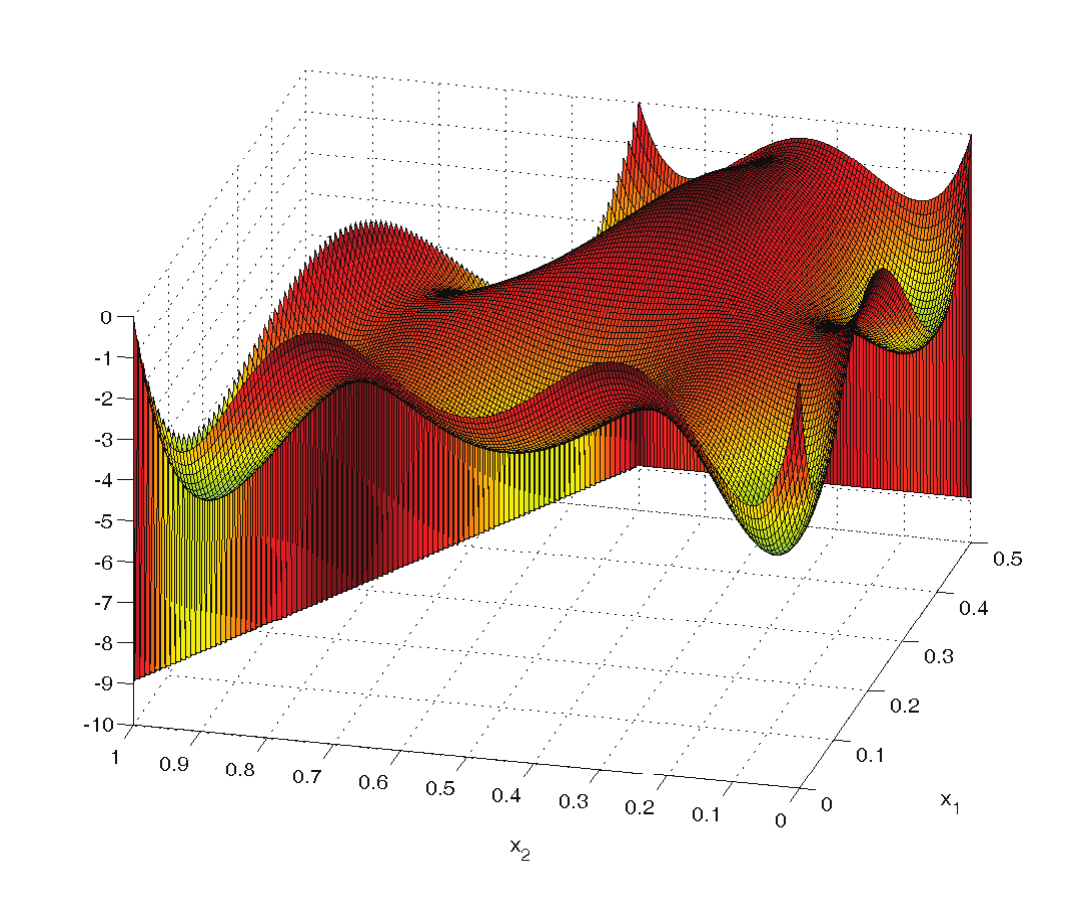
Fig 3. The plot of the directional derivative of the ProjPSO-generated design confirms that x 3 model without the 3-way interaction term on the irregular 3-simplex with